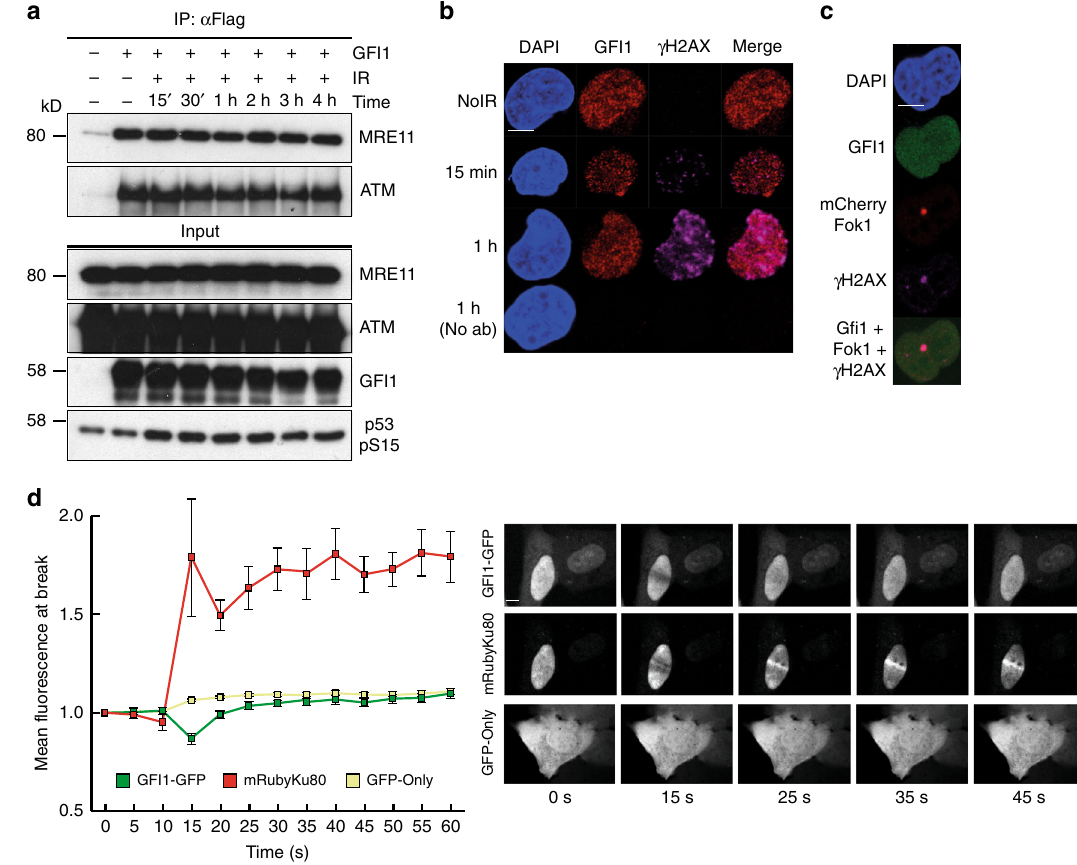
Fig. 4 GFI1 activities are independent of DNA damage. a GFI1-Flag fusion protein was immunoprecipitated in 293T cells treated with 5 Gy IR and allowed to recover for the indicated amount of time. Extracts were separated by SDS – PAGE and blotted for the indicated proteins. b SupT1 cells were spread on glass slides 15 min and 1 h after irradiation using a Cytospin, stained for endogenous G fi 1 and γ -H2AX and visualized for immuno fl uorescence by confocal microscopy. Control cells stained without primary antibody but with secondary antibodies are shown. c U2OS cells carrying a LacO array and expressing a LacR-Fok1-mCherry endonuclease were transfected with a vector expressing the GFI1-GFP fusion protein. These cells were plated on cover glass, stained for γ -H2AX and visualized for immuno fl uorescence by confocal microscopy. d U2OS cells expressing a GFI1-GFP fusion protein were exposed to 405 nm UV micro-irradiation and the recruitment of the GFI1-GFP fusion protein to the site of damage was quanti fi ed by confocal microscopy. Average signal intensity is shown with error bars representing s.d. Recruitment of Ku80-mRuby2 fusion protein and GFP protein are shown as controls. Representative images of selected time points are shown on the right. Scale bar represents 10 μ